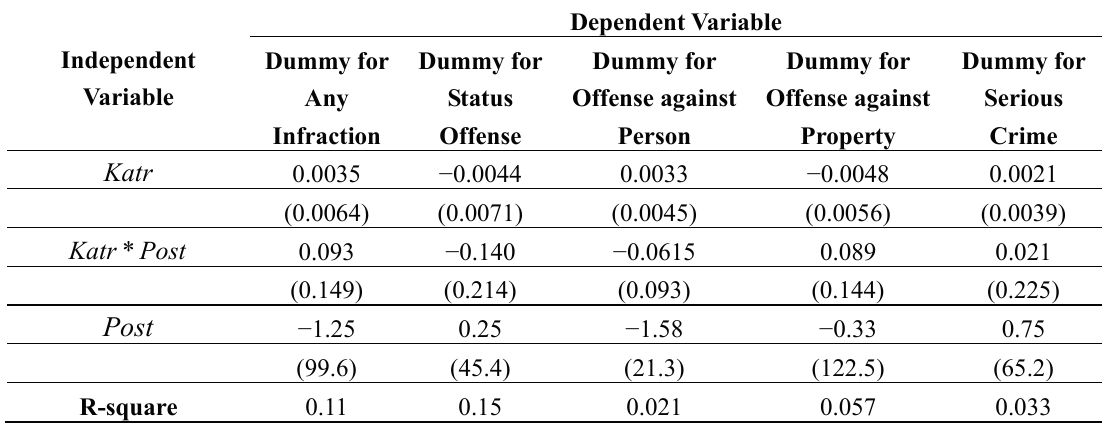
Table 4. Falsification Test for Parallel Trend Assumption (N =